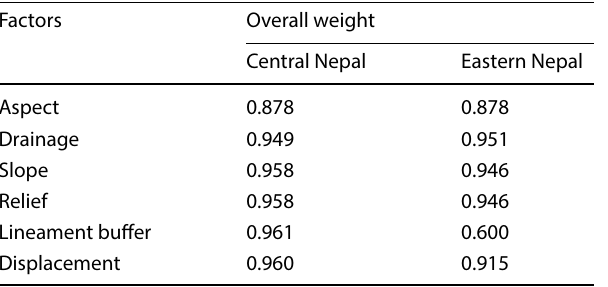
Table 6 Percent influence of each factor obtained from the overall